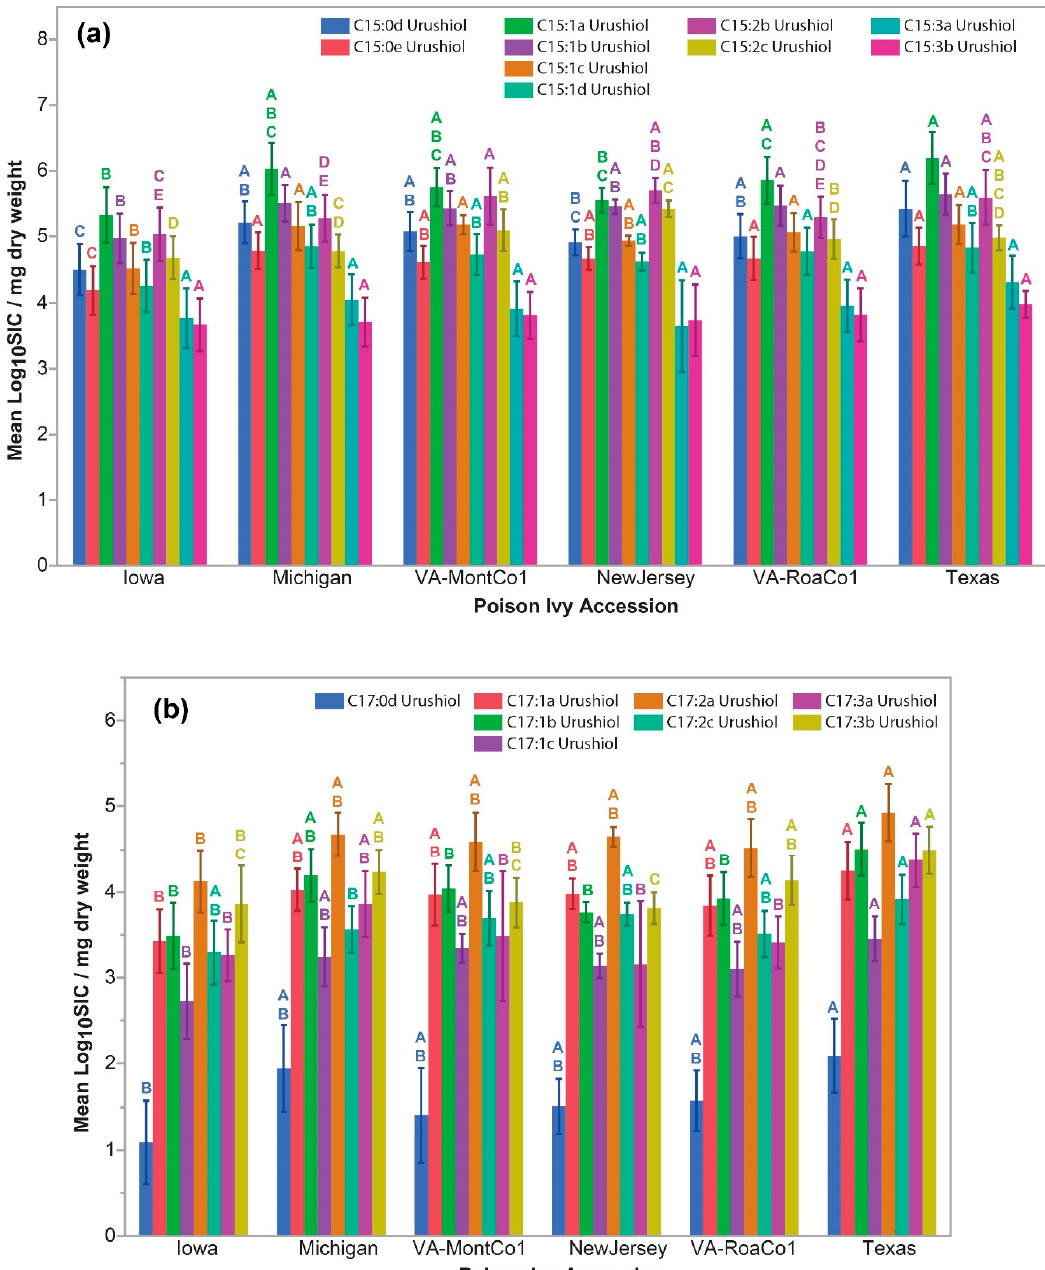
Figure 3. Steady state C15- and C17-urushiol congener and isomer accumulation levels. ( a ) C15-urushiols, ( b ) C17-urushiols. Error bars indicate standard deviation. Non-shared letters of the same color indicate statistically significantly di ff erent least square means between the poison ivy